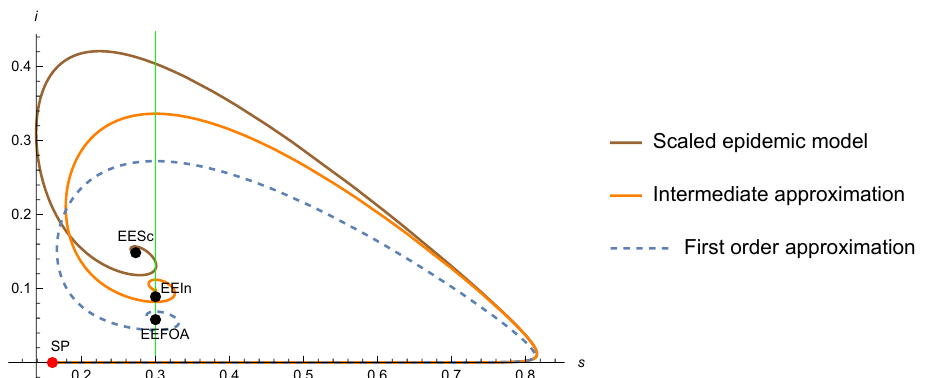
Figure 1. Parametric ( s , i ) plots of the scaled epidemic (9) and its FA (12) and intermediate ap- proximations for a SIR-type model with one infectious class, starting from a starting point SP with i 0 = 10 − 6 , R = 3.21, critical vaccination 0.622222, and γ s = 0.01. The other parameters are β = 5, γ = 1/2, Λ = µ = 1/10, γ r = 1/6, ν i = 0.9, ν r = 0. EESc , EEIn , EEFOA are the stable endemic points of the scaled model, intermediate model, and the FA model, respectively. The green vertical line denotes the immunity threshold 1/ R = s EEFOA = s EEIn . Note that the epidemic will at first spend a long time (since births and deaths have slow rates as compared to the disease) in the vicinity of the manifold (cid:126) i ( t ) = 0, where the three processes are indistinguishable, before turning towards the endemic equilibrium point(s).